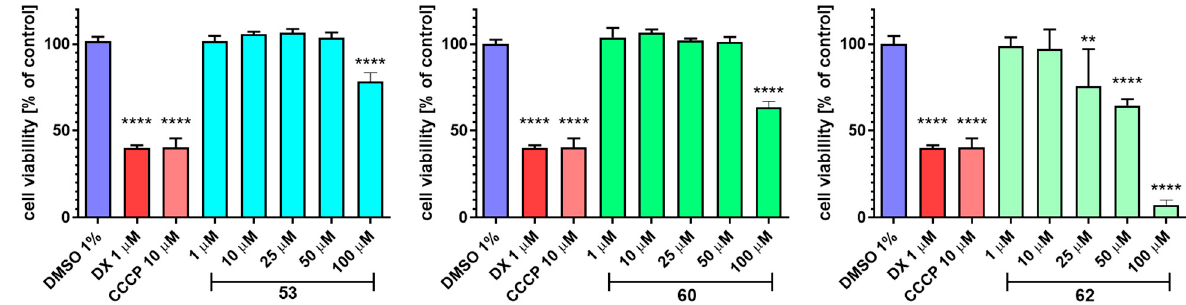
Figure 7. The effect of 53 , 60 , and 62 , cytostatic drug doxorubicin (DX) and the mitochondrial toxin CCCP on the hepatoma HepG2 cell line viability after 72 h of incubation at 37 °C, 5% CO 2 . The data were analyzed with one-way ANOVA, followed by Bonferroni’s Comparison Test (Graph Pad Prism 8.0.1 software, San Diego, CA, USA)): ** p < 0.01, **** p < 0.0001 vs. negative control (DMSO 1% in growth media).